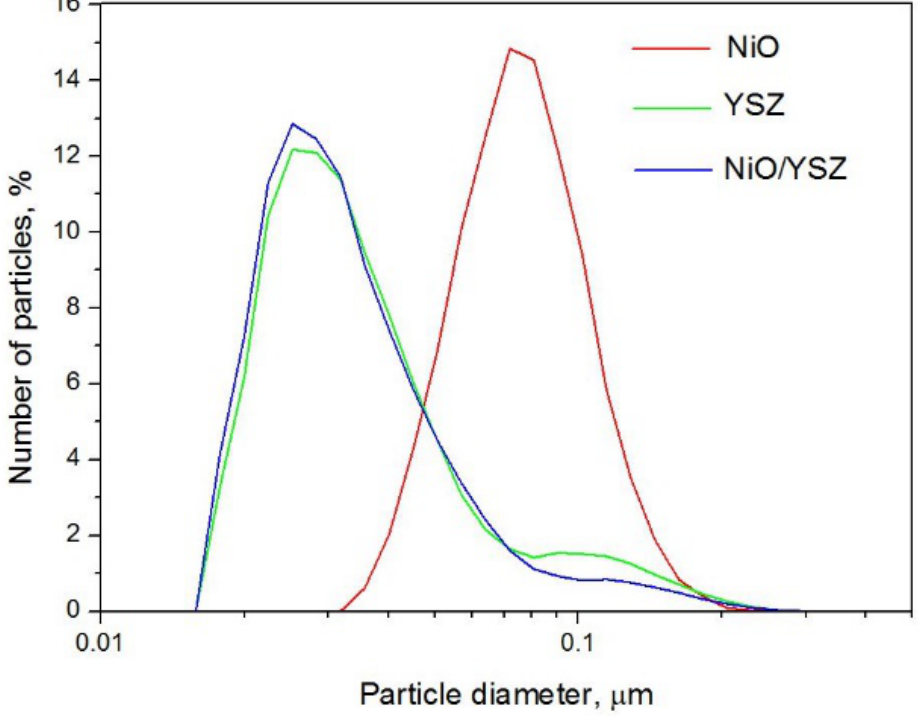
Figure 3. Particle size distribution for NiO, YSZ and NiO/YSZ composite.